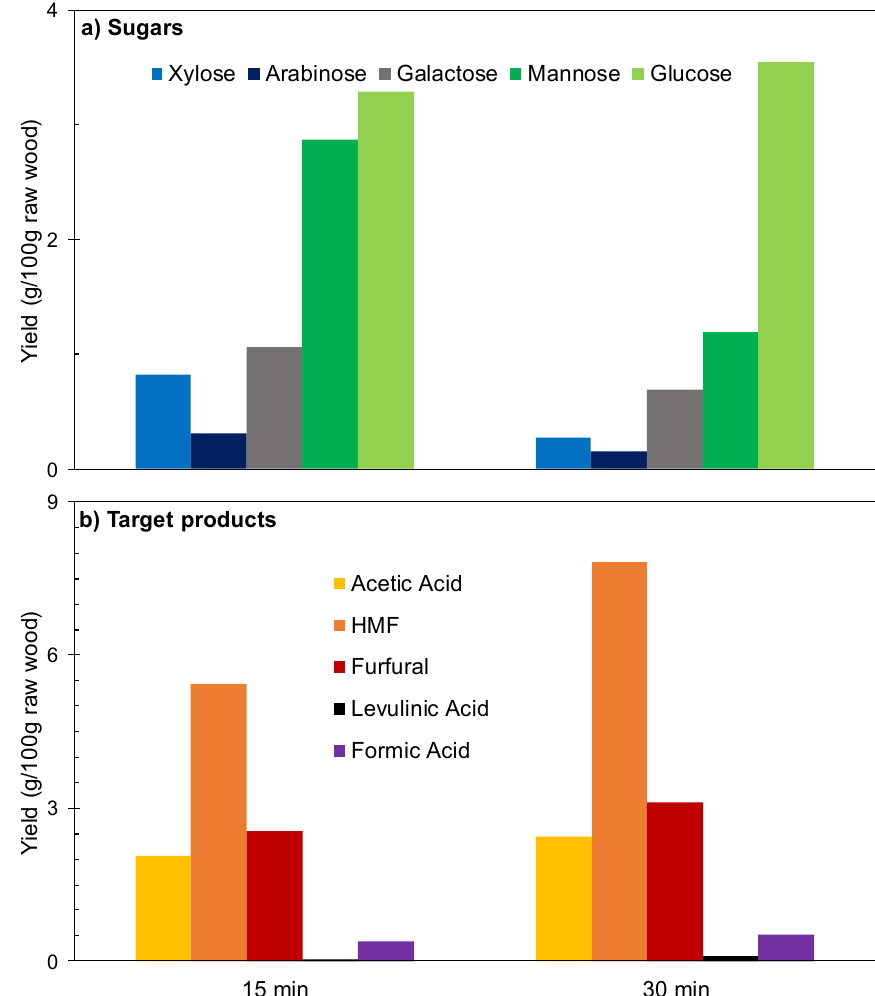
Figure 5. Overall yields (including the contributions of aqueous and organic phases) achieved in experiments performed at 190 °C using [C4mim]HSO 4 as a catalyst. ( a ) Sugars ( b ) Target products.